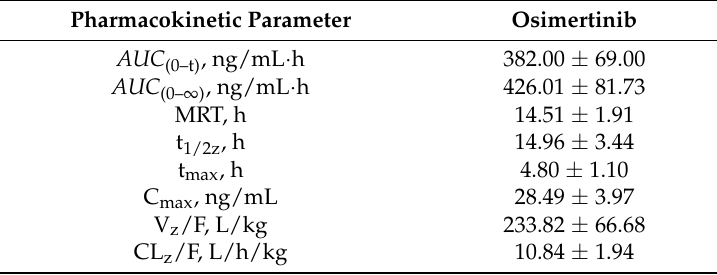
Figure 4. Plasma concentration-time profile after single oral administration of osimertinib (4.5 mg/kg) to rats. Data are expressed as the mean ± SD ( n = 7). Table 5. Pharmacokinetic parameters of osimertinib after oral administration of 4.5 mg/kg to rats.